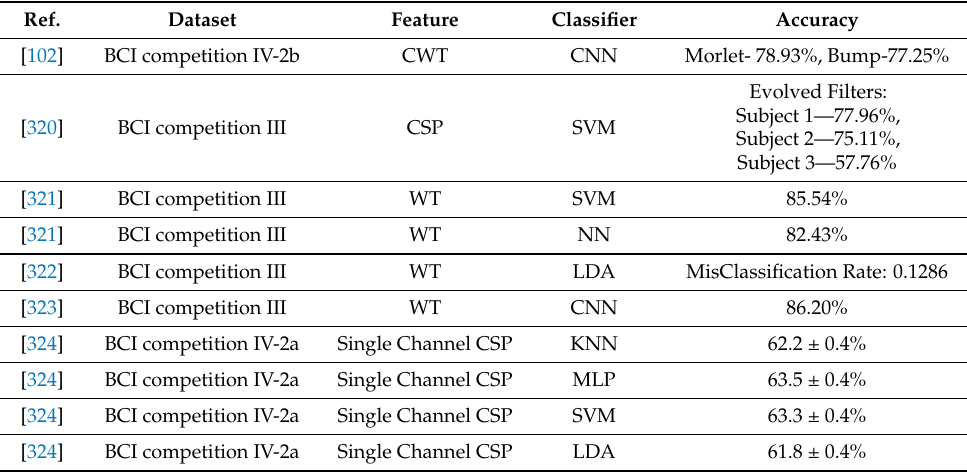
Table 9. Comparison of classifiers based on popular datasets and features.